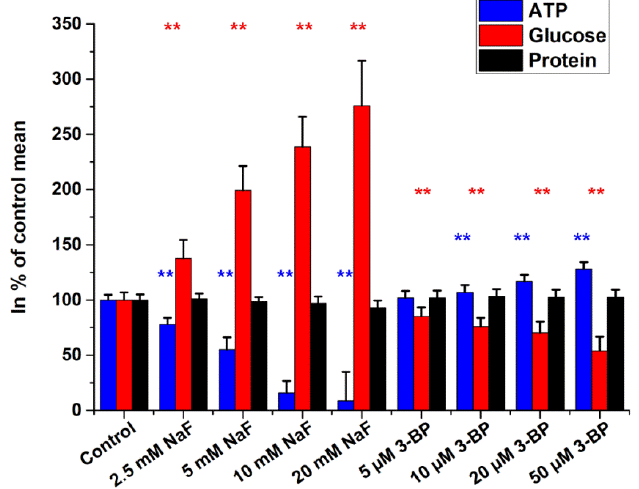
NaF (20 mM), ATP level was approximately 9% and glucose was 275% of the control value. Opposite glucose. No change in protein concentration was detected.